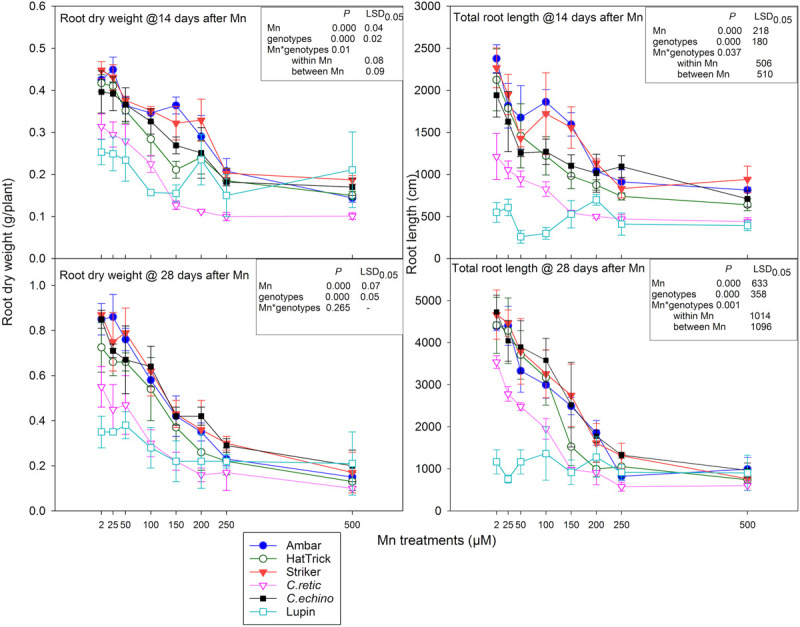
Root dry weight (g/plant) and total root length (cm/plant) at 14 and 28 days after Mn treatments of Cicer genotypes and lupin. Vertical bars where visible represent the standard error of the mean.